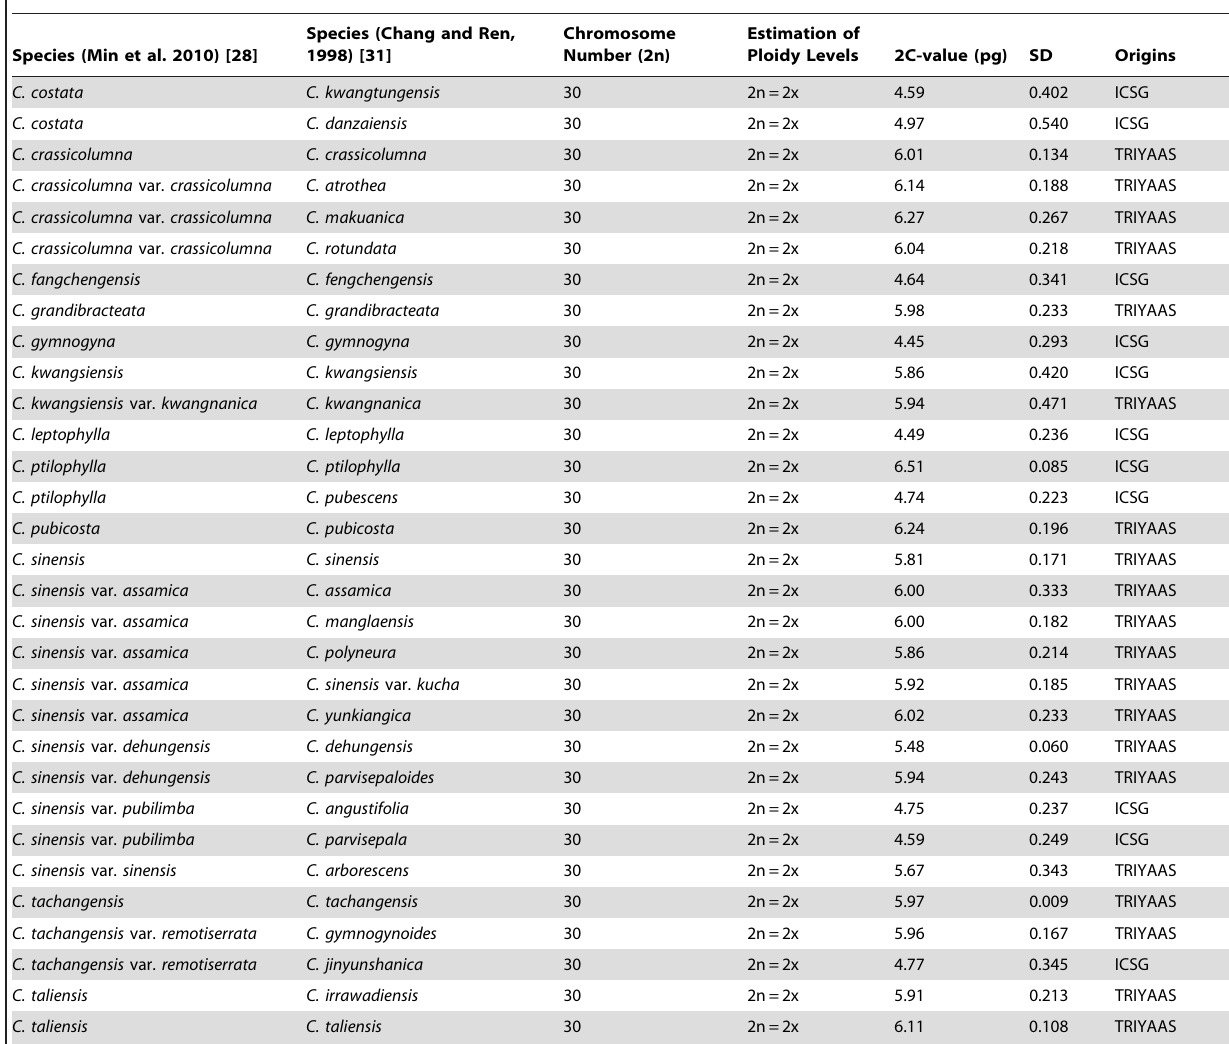
Table 3. Nuclear DNA amount of the section Thea species estimated with flow cytometry.